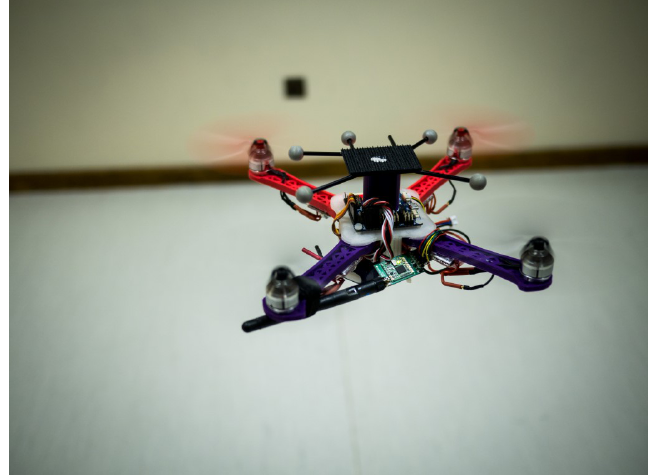
Figure 1. A quadrotor micro air